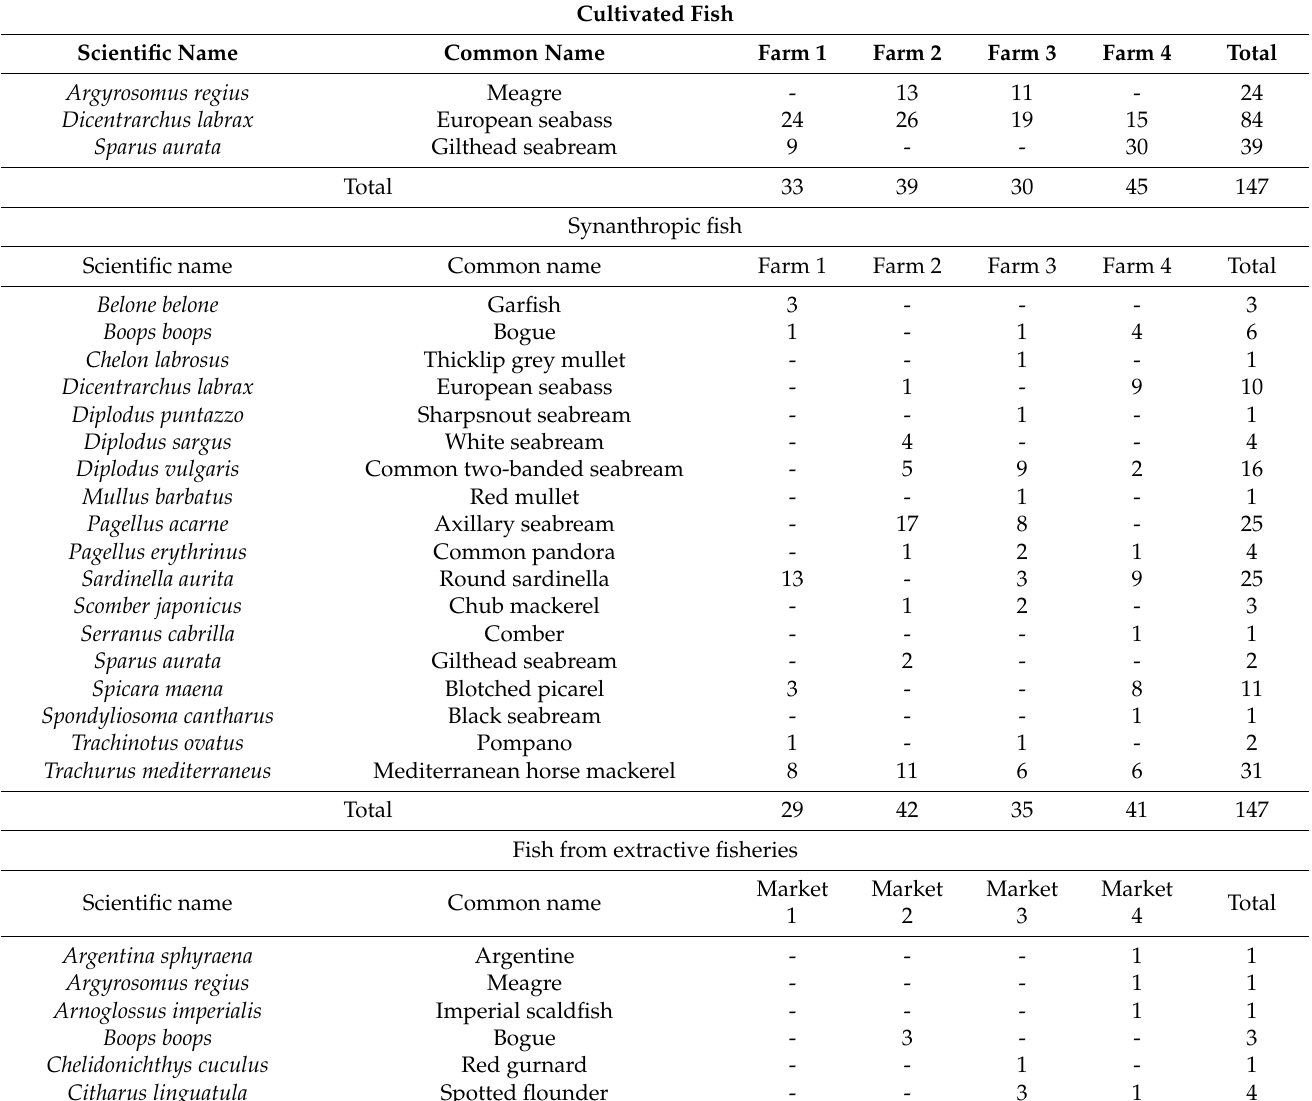
Table 1. Marine fish collected in the present study depending on the species, group and location. Cultivated